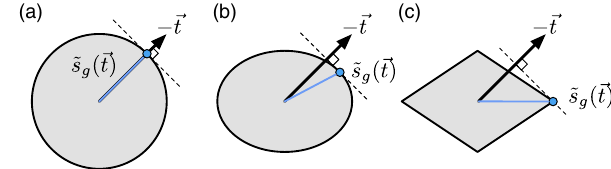
FIG. 5. Gaussian anchor points, with mapping from ⃗ t to points ⃗ t Þ , showing the relation between − ⃗ t and the point on the ˜ s g ð manifold that touches a hyperplane orthogonal to ⃗ t . D ¼ 2 manifolds shown are (a) circle, (b) l 2 ellipsoid, (c) polytope manifold. In (c), only for values of ⃗ t of measure zero (when ⃗ t is exactly perpendicular to an edge) will ˜ s otherwise it coincides with a vertex of the polytope. In all cases, ⃗ t Þ will be in the interior of the convex hulls only for ⃗ t ¼ 0 . ˜ s g ð Otherwise, it is restricted to their boundary.